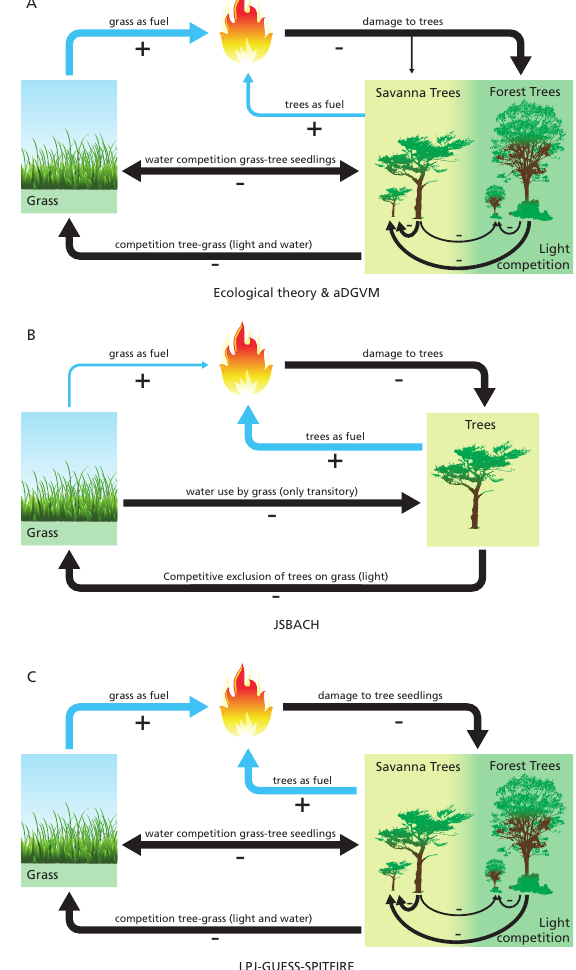
Figure 3. Schematic diagram of the main ecological interactions that determine the forest–savanna–grassland transition, according to (a) Ecological theory and the aDGVM; (b) JSBACH; (c) LPJ- GUESS-SPITFIRE. Light arrows represent positive effects, dark ar- rows negative effects. The aDGVM (a) was designed to include the key ecological mechanisms known from theory, namely that grasses increasing fire spread (positive feedback), the distinction between forest and savanna trees (with fires damaging forest tree mostly, shade-intolerant savanna seedlings and shade-tolerant forest seedlings), separate resource competition between trees and grasses depending on their size (grasses and tree seedlings compete for the same water, while adult trees outcompete grasses for both water and light). JSBACH (b) includes fires as mainly fostered by the litter of trees, which are also mainly damaged by fire (negative feedback). Trees competitively exclude grasses, although temporarily after dis- turbances grasses also compete with them for the same water. LPJ- GUESS-SPITFIRE (c) is on one hand similar to the aDGVM, since it distinguishes between tree life stages and it separates savanna and forest trees, with analogous representation of water and light tree– grass competition. On the other hand, it includes similar effects of tree and grass biomass in fostering